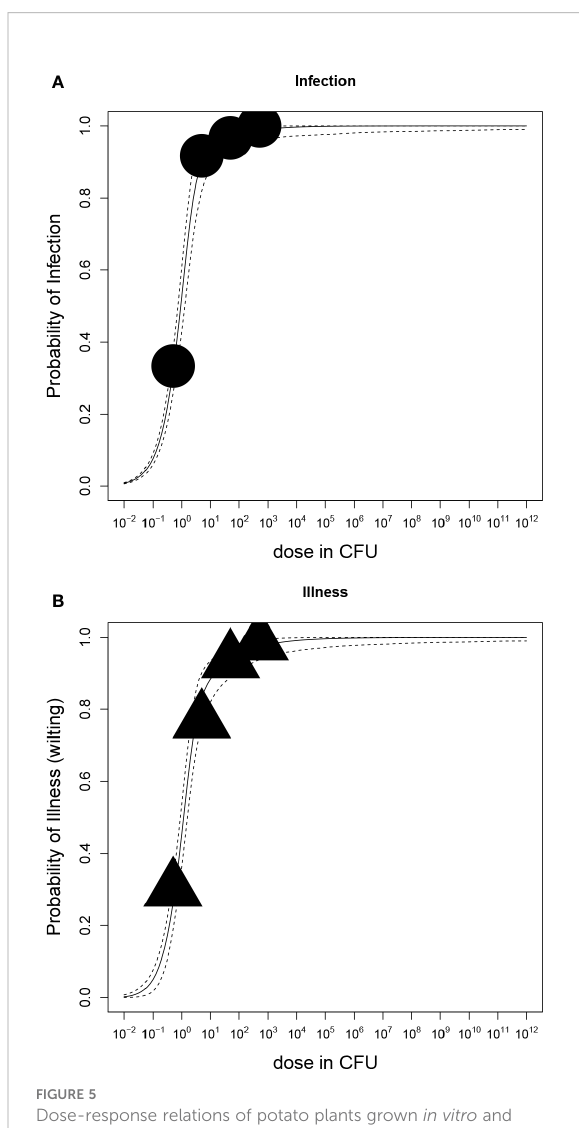
FIGURE 5 Dose-response relations of potato plants grown in vitro and Ralstonia solanacearum ); (A) Probability of stem-infection with increasing dose in colony forming units (CFU); (B) Probability of illness (symptomatic plants) with increasing dose. Each graph shows the median and 95% range of the probability of infection or illness, indicated by the dashed line, calculated by the dose- response model as a function of dose. Available data are shown as a bubble chart (symbol size proportional to the number of plants